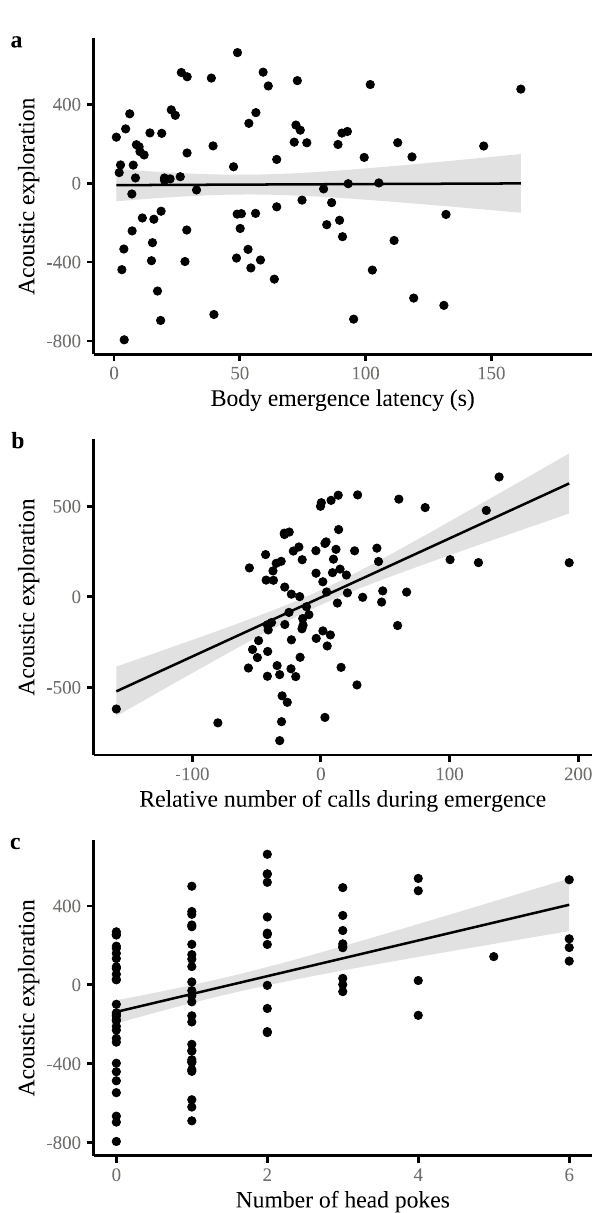
Figure 4. Acoustic exploration, i.e., residuals of the number of echolocation calls as a function of the number of chambers visited, in relation to other behavioral responses exhibited by Nathusius’ pipistrelles in a novel environment. These behavioral responses exhibited in the novel environment (a maze-like arena) included: ( a ) Body emergence latency (s), ( b ) Acoustic exploration during emergence, i.e., the residuals of the number of echolocation calls as a function of emergence duration (time between the head out and the body out of the starting tube), ( c ) the number of times a bat poked its head into an adjacent chamber without entering. Regression lines show the predicted final model values. Shaded areas around the lines reflect the 95% Confidence